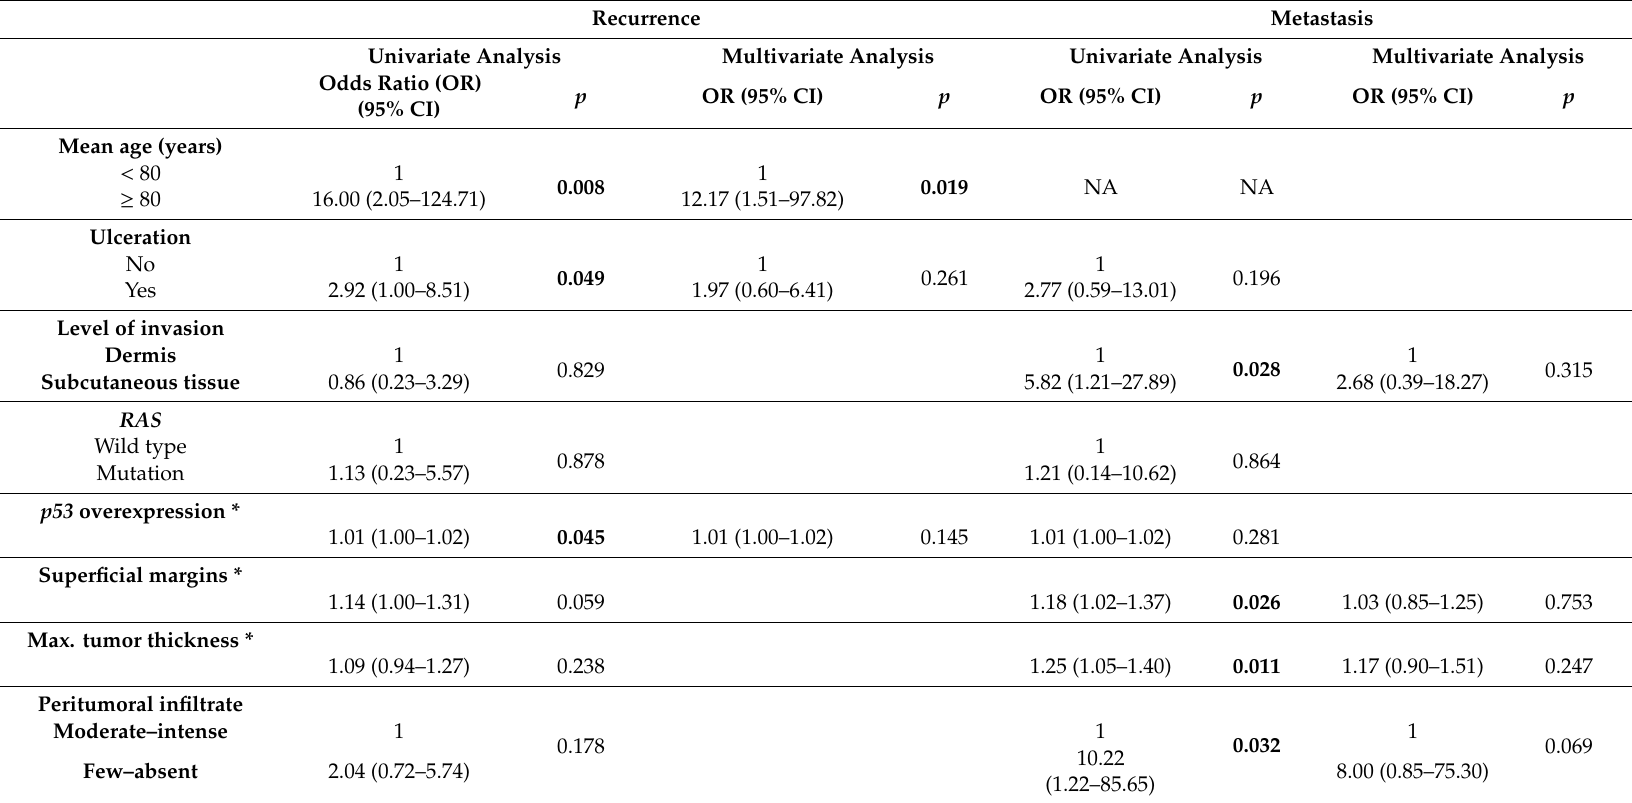
Table 2. Predictive factors for recurrence and lymph node